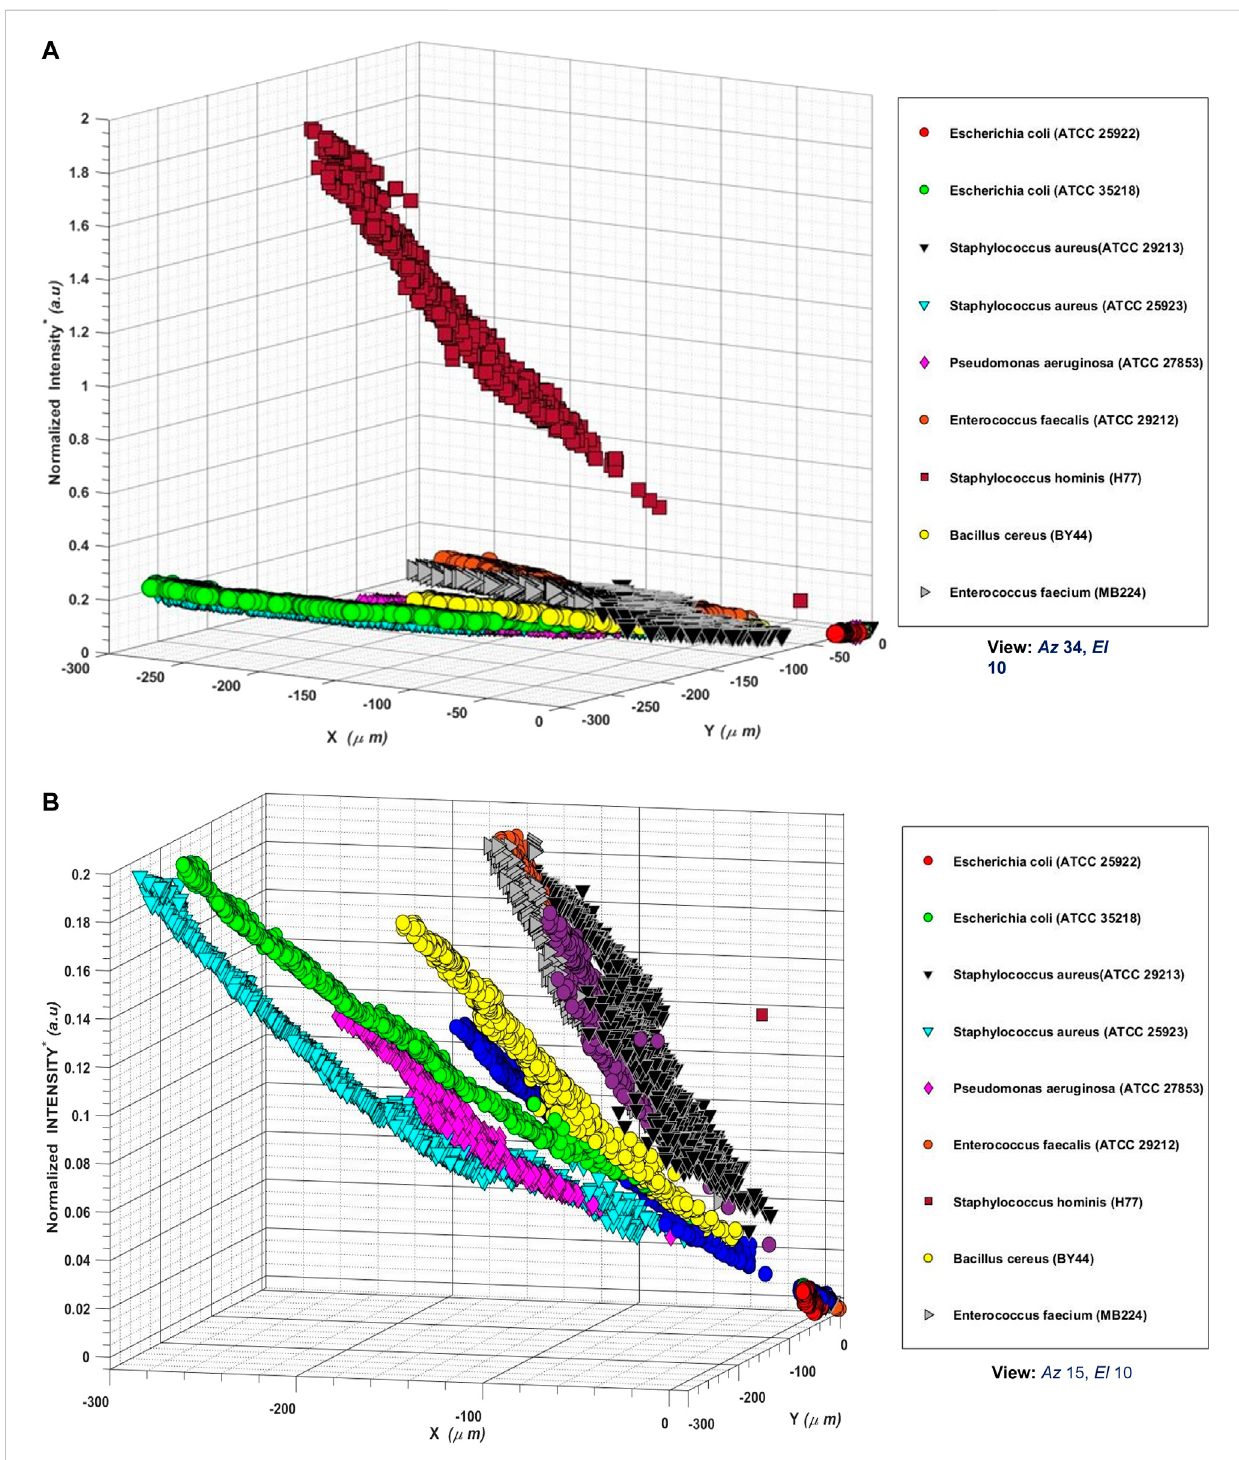
FIGURE 4 (A) Three-dimensional scatter plots of backscattered light detected by the photodetector of AUM photonic system when aerosols laden with differentbacterialsampleswereinjectedintotheinterrogationvolumeoflightscattering.Theplotsshow x,y positions(in µm ) ofthebackscatteredbeam and normalized intensity (in au ) of backscattered beam, time averaged (for every 1 s). The plots show the relative changes in x, y positions (in µm ) of the backscattered beam and the normalized intensity (in au ) of backscattered beam, time averaged (for every 1 s). Intensity values were normalized by dividing them with the pre-injection concentration values of the species for each trial. The multiplication factor of 10 – 8 in the normalized intensity values is not shown on the vertical axes, to avoid clutter in the plot. (B) Three-dimensional scatter plots of backscattered light detected by the photodetector of AUMphotonicsystemwhen aerosols laden with differentbacterial samples wereinjected into theinterrogation volume oflightscattering.This fi gure isa zoomed in (in the Z axis) version of Figure 4A, from a different